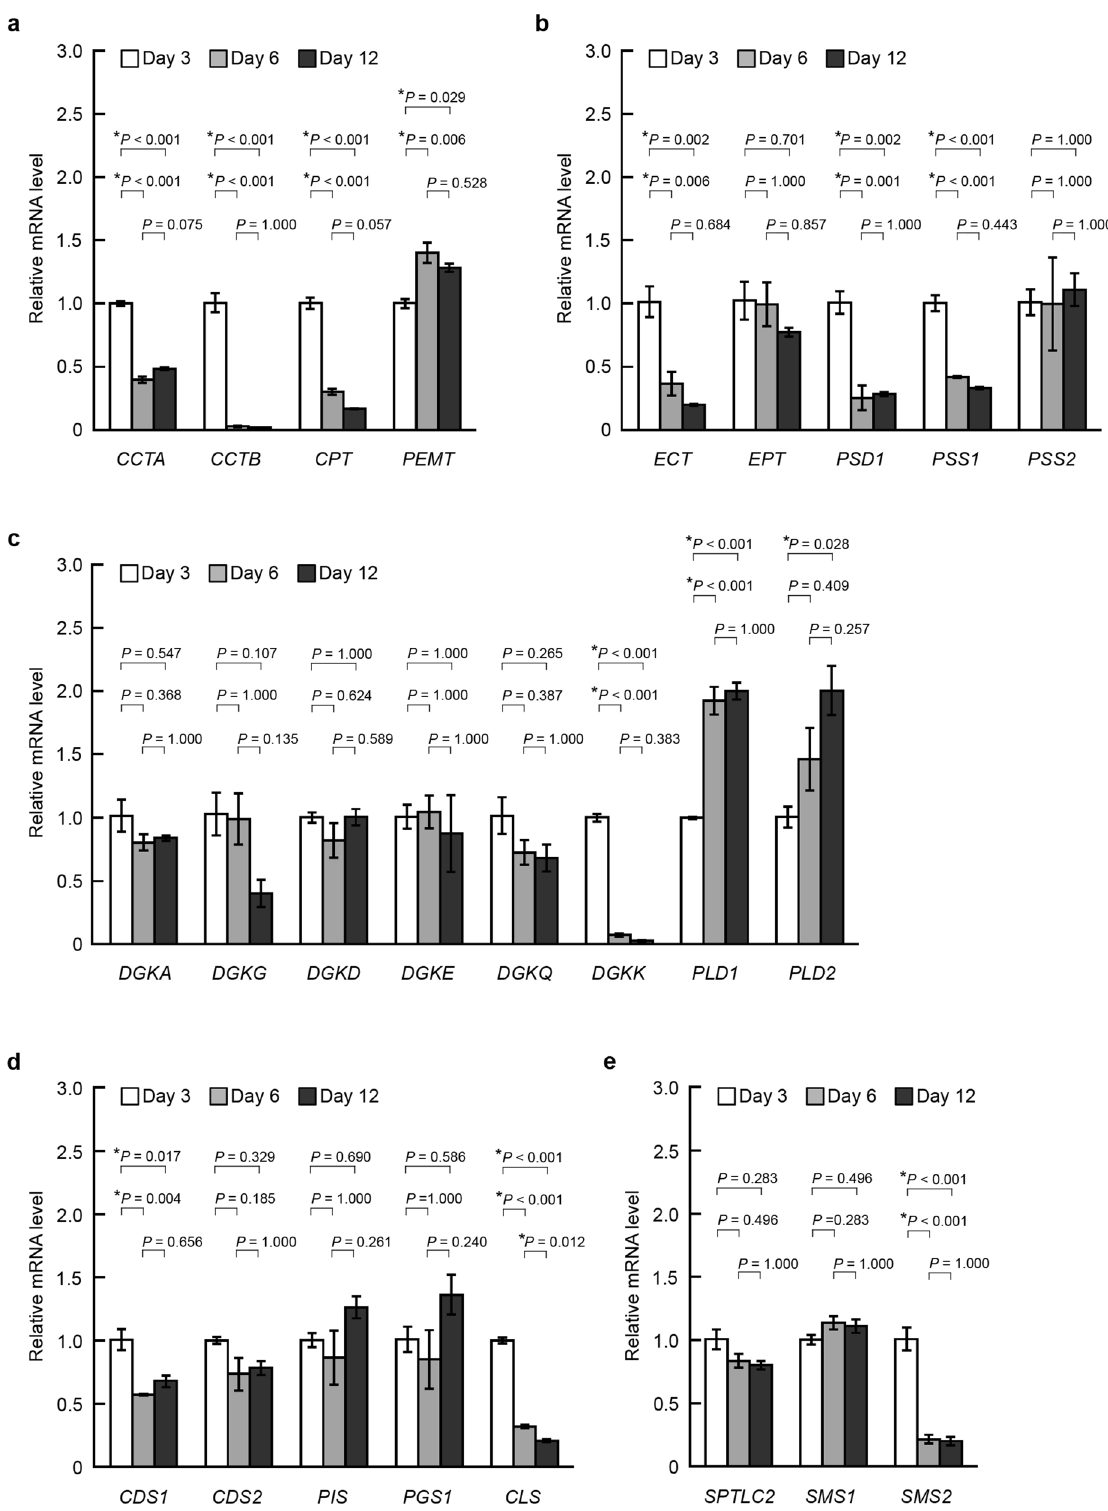
Figure 3. mRNA expression changes of phospholipid synthesis-related enzymes in HepG2 cells during cell growth. Relative mRNA expression of CCTA , CCTB, CPT and PEMT ( a ) , that of ECT, EPT , PSD1 , PSS1 and PSS2 ( b ), that of DGKA , DGKG, DGKD, DGKE, DGKQ, DGKK, PLD1 and PLD2 ( c ), that of CDS1 , CDS2 , PIS , PGS1 and CLS ( d ), and that of SPTLC2 , SMS1 and SMS2 ( e ) in HepG2 cells at Day 3 (early logarithmic phase), Day 6 (late logarithmic phase) and Day 12 (stationary phase). The Ct value was normalized to the mean Ct value of HPRT1 and RPLP0 . The mRNA expression relative to the mRNA expression level at Day 3 was measured (mean ± S.E., n = 3, * P < 0.05, significantly different among Day 3, Day 6 and Day 12, one-way ANOVA followed by the Bonferroni